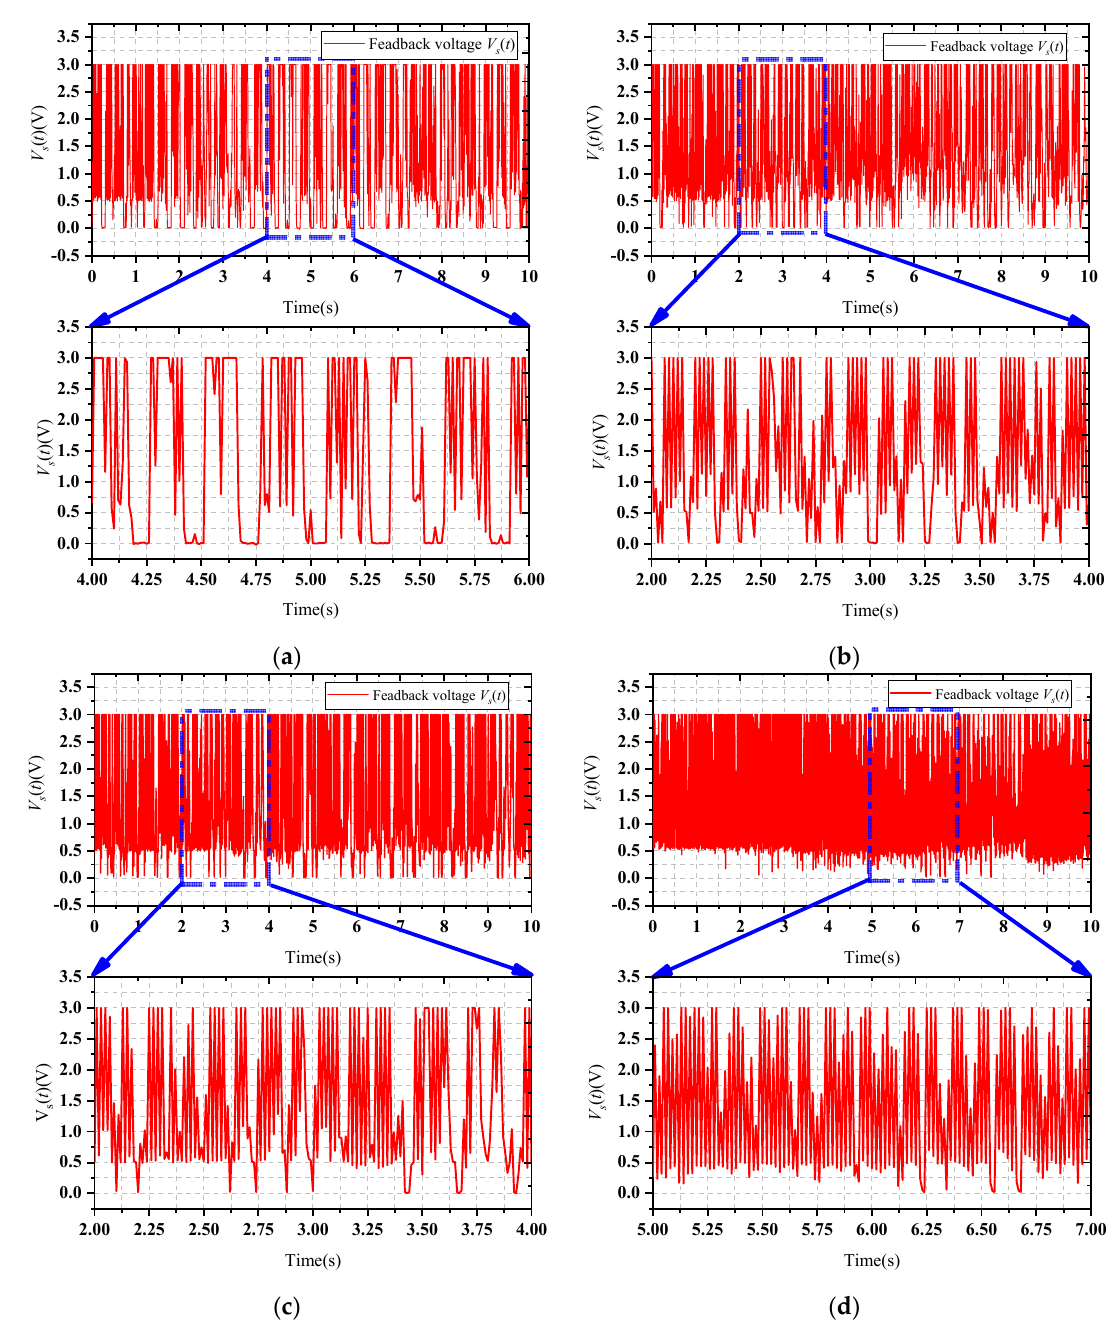
Figure 12. Inter-electrode feedback voltage. ( a ) Traditional micro-EDM. ( b ) Conventional PID control magnetic actuator and traditional micro-EDM cooperative control. ( c ) Fuzzy PID control magnetic actuator and traditional micro-EDM cooperative control. ( d ) Variable domain fuzzy PID control magnetic actuator and traditional micro-EDM cooperative control.